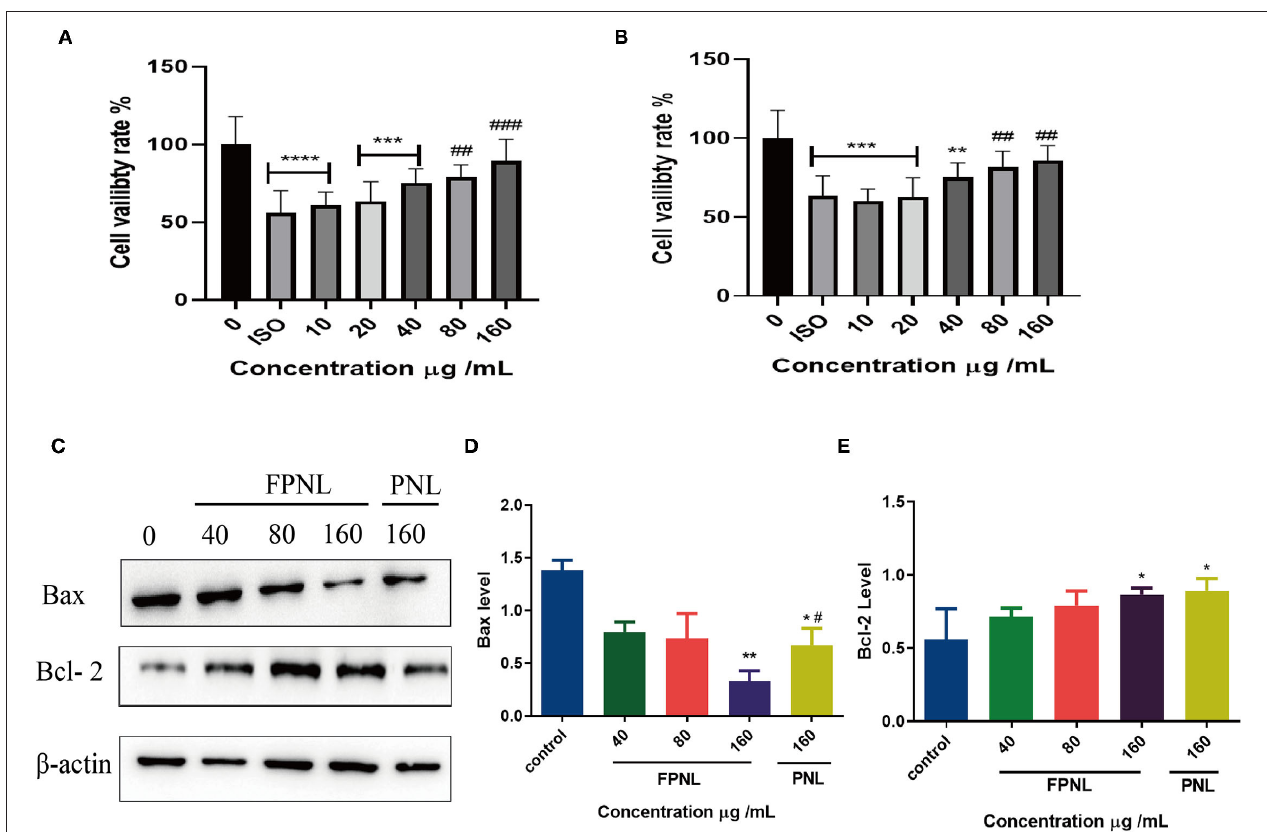
FIGURE 5 | The effect of PNL and FPNL on ISO-induced H9c2 cell apoptosis. (A) Alleviated of the proliferation of H9c2 cells by different concentrations of FPNL. (B) Alleviated of the proliferation of H9c2 cells by different concentrations of PNL. (C–E) Expression of apoptotic proteins (Bax, Bcl-2) in HCT116 cells. Data are expressed as mean ± SEM from three independent experiments ( n = 3). * P < 0.05, ** P < 0.01, *** P < 0.001, **** P < 0.0001 vs. control. # P < 0.05, ## P < 0.01, ### P < 0.001 vs. FPNL (160 µ g/ml)